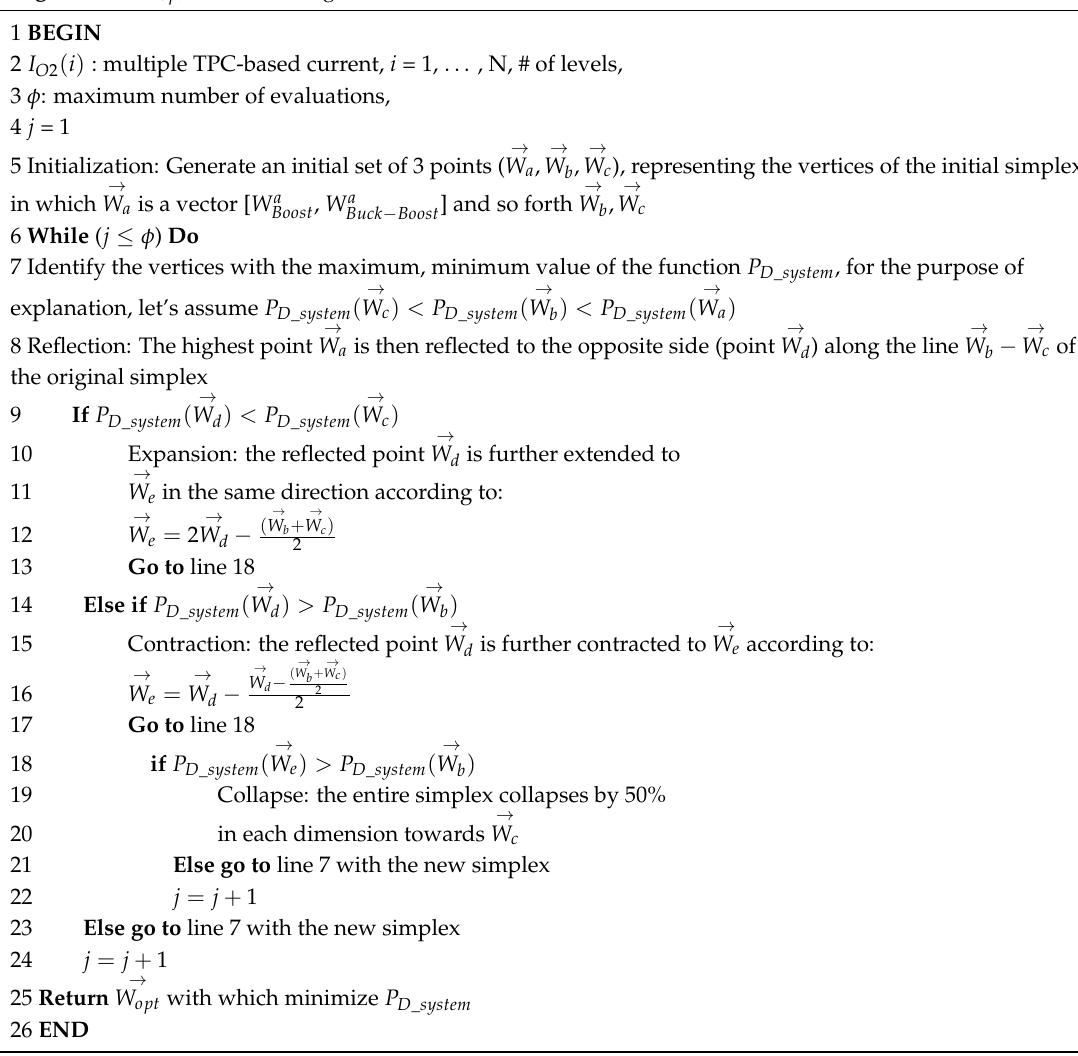
Algorithm 2 W opt calculation